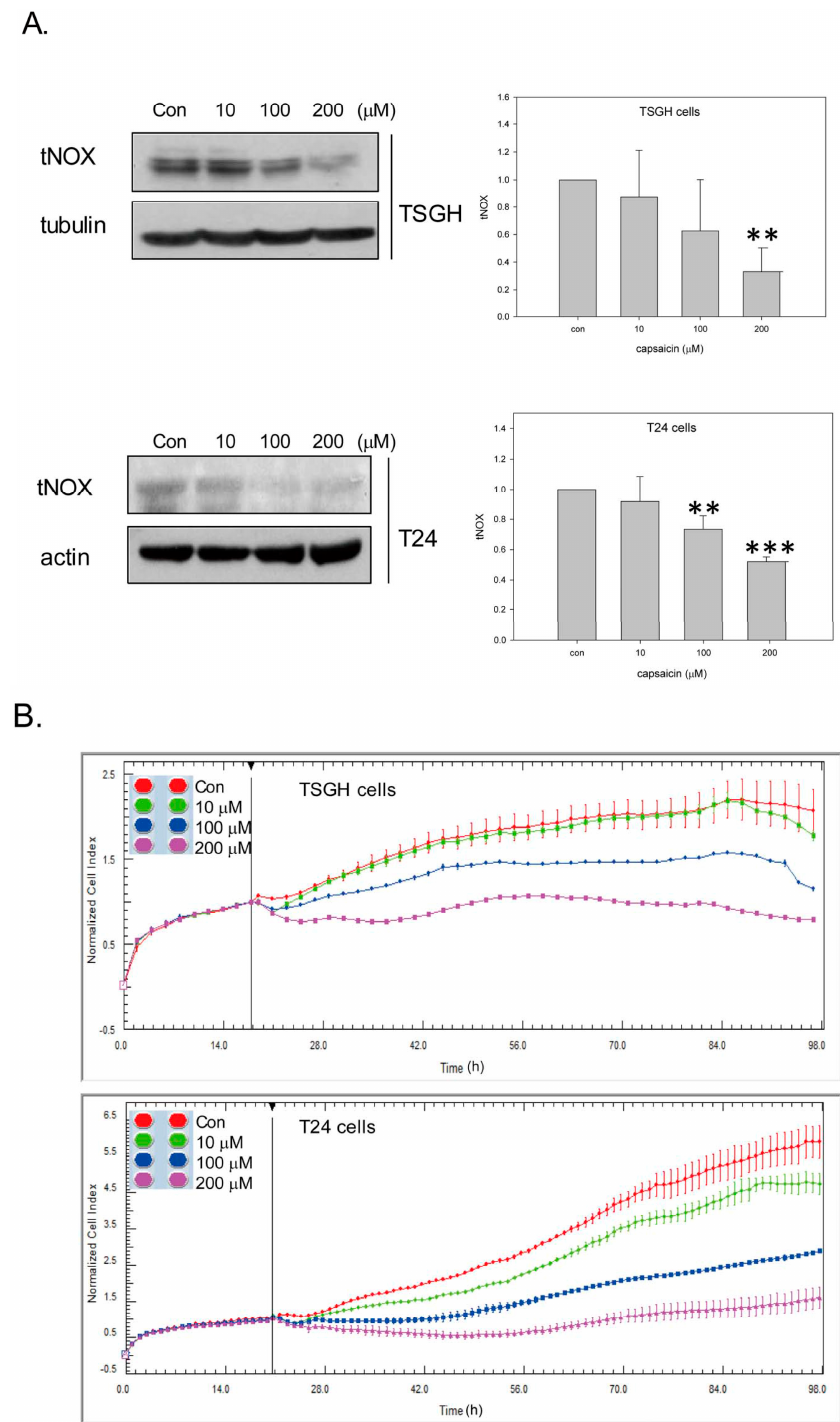
Figure 1. Capsaicin downregulates tNOX expression and inhibits cell growth in TSGH8301 (herein called TSGH) and T24 cells. ( A ) Cells were treated with capsaicin or ethanol for 18 h. Aliquots of cell lysates were separated by SDS-PAGE and analyzed by western blotting; β -actin (or tubulin) was used as an internal control. Representative images from four experiments are shown. The intensity of a protein band was quantified by Gel-Pro Analyzer software 3.1. The resultant values of protein expression were normalized to those of actin. Values (mean ± SE) are from three independent experiments (** p < 0.01, *** p < 0.001); ( B ) Cell growth with or without capsaicin was dynamically monitored using impedance technology. Normalized cell index values measured over 96 h are shown.